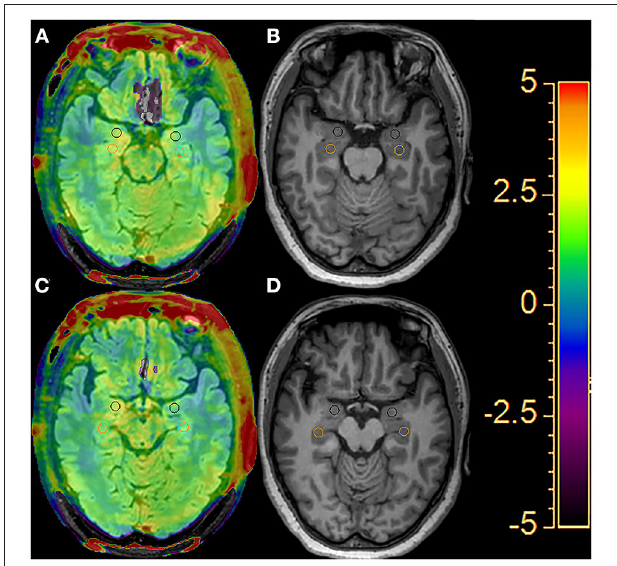
FIGURE 1 | An example of the definition of the regions of interest (ROIs) of the bilateral hippocampus (orange circle) and amygdala (black circle) for quantitative analyses. Two consecutive layers of the FLAIR image with APTw overlay (A, C) and the T1-weighted image (B, D) .